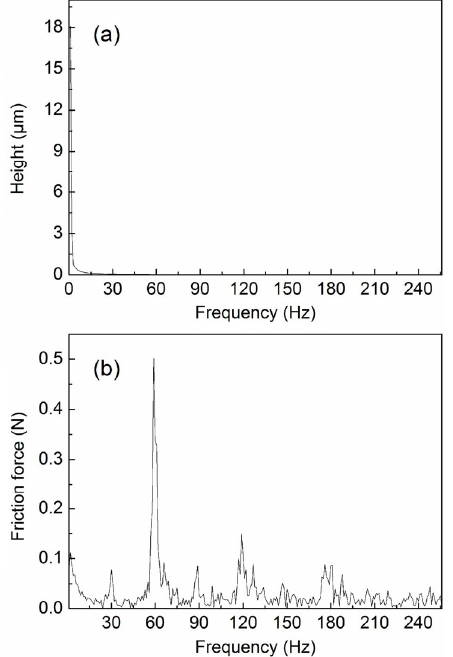
Fig. 8 (a) FFT of the aluminum plate surface roughness; (b) FFT of the